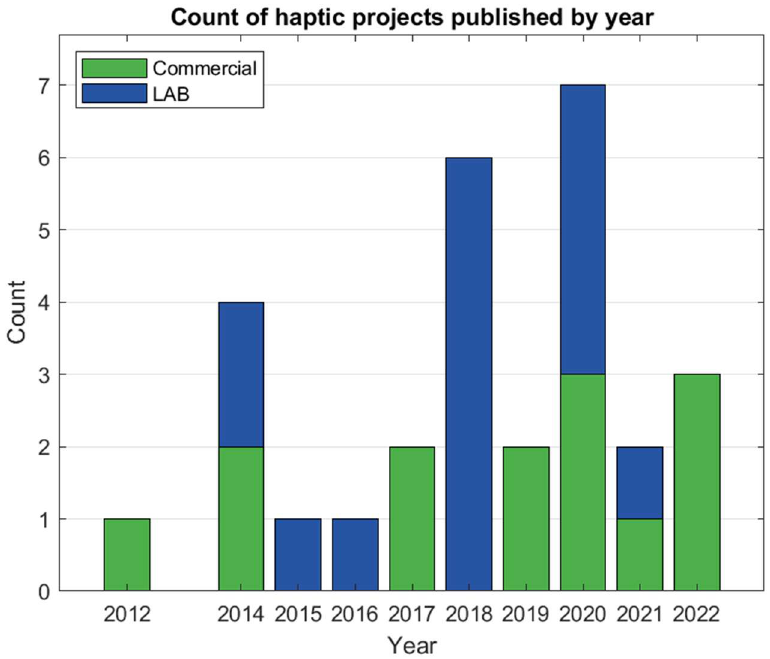
Figure 1. The number of academic and industrial studies included in this paper by year.